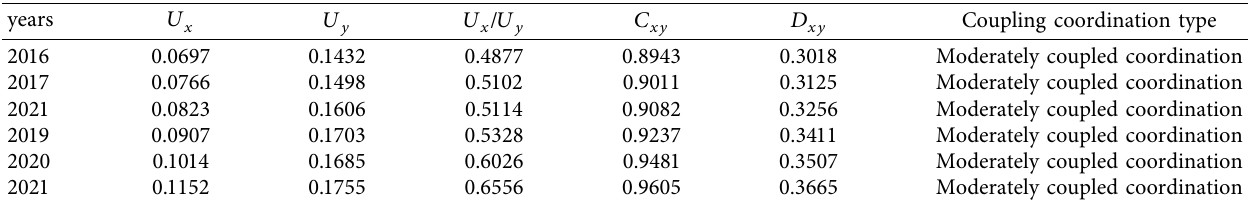
Table 3: The general characteristics of cooperation and collaboration between the digital economy and sustainable development. years